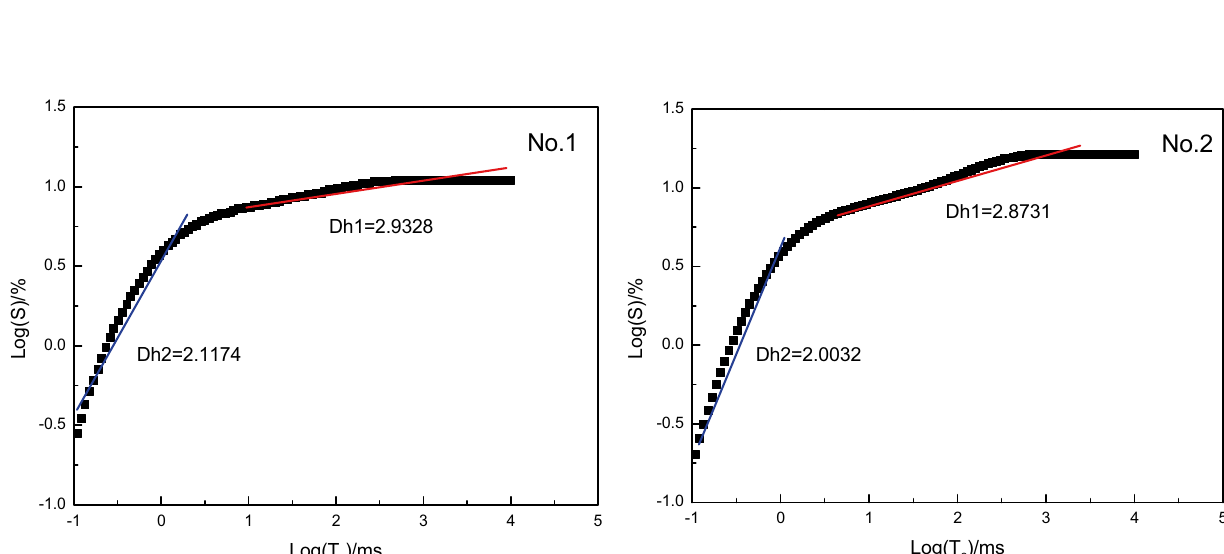
Fig. 17 Nuclear magnetic resonance T